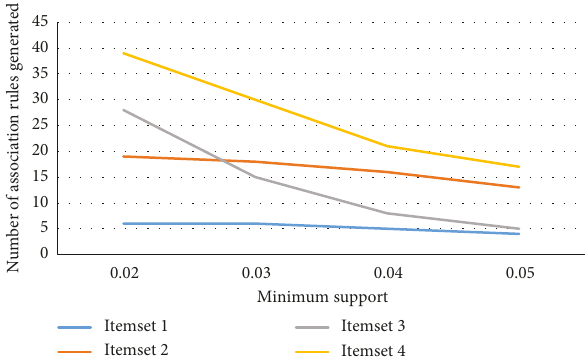
Figure 5: The trend of the number of Boolean association rules with the number of itemsets.